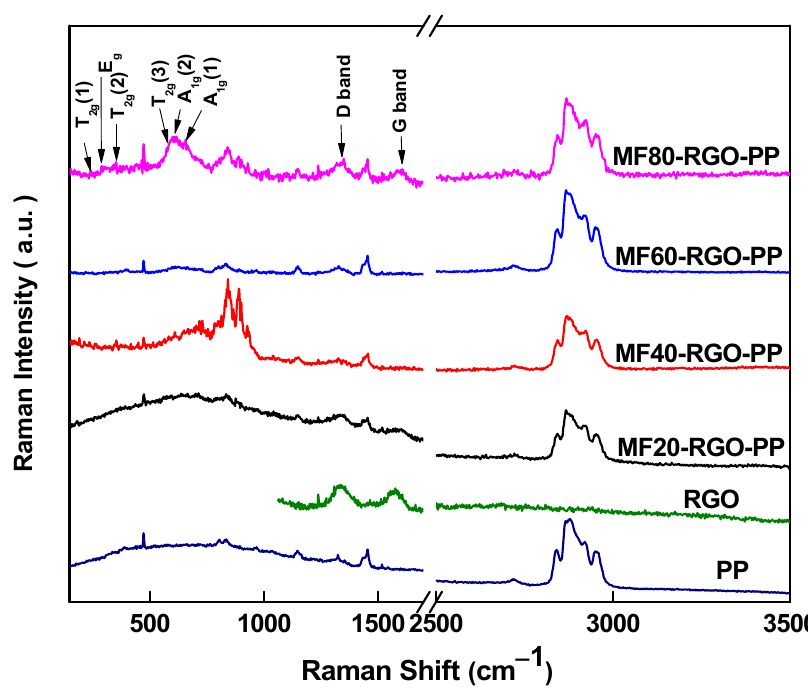
Figure 7. Raman spectrum of (a) polypropylene (PP), (b) reduced graphene oxide (RGO), (c) MF20-RGO-PP, (d) MF40-RGO-PP, (e) MF60-RGO-PP and (f) MF80-RGO-PP.